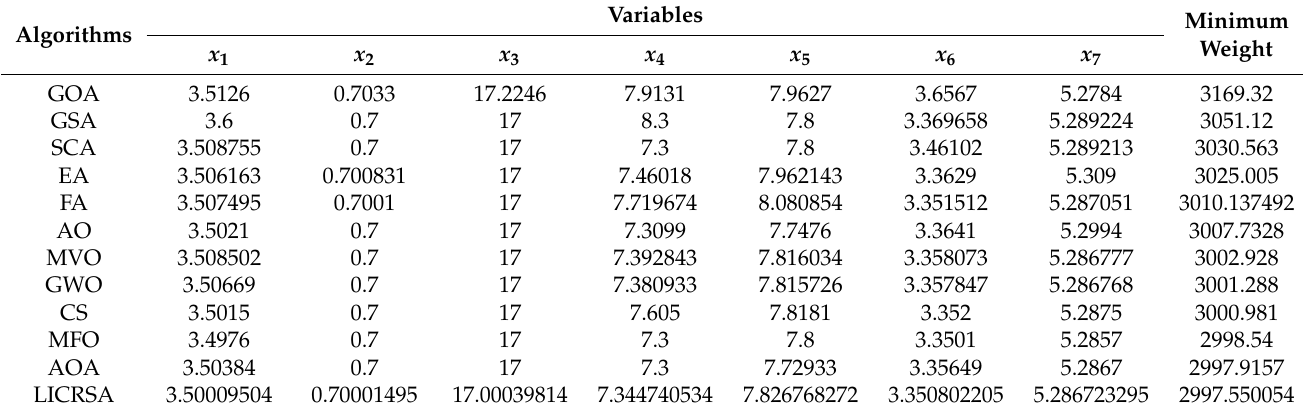
Table 21. Numerical comparison of the results obtained for the speed reducer design in the literature.